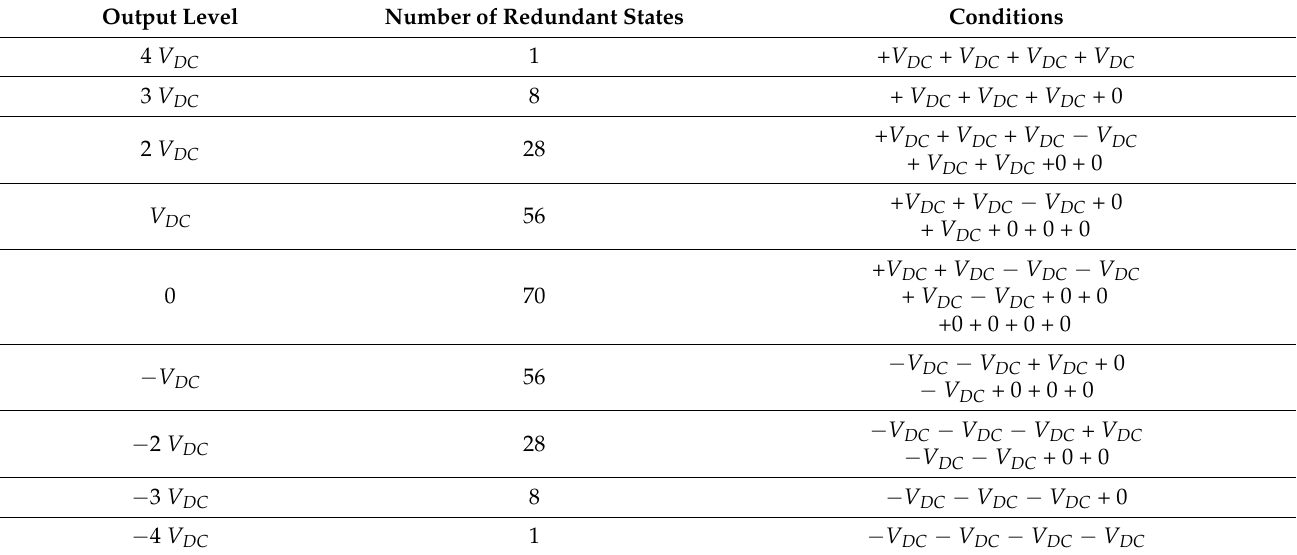
Table 5. Redundant states for the cascaded four submodules